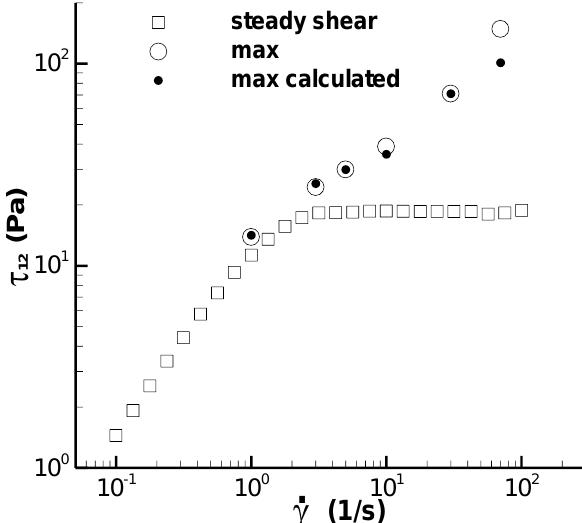
Figure 2. Maximum shear stress in step rate experiment and the steady shear stress of the CPyCl/NaSal solution. The square symbol is the steady experiment in Figure 6 of Pipe et al. [3], the circle is the transient experiment in Figure 13 of Pipe et al. [3], and the solid circle is the calcula- tion